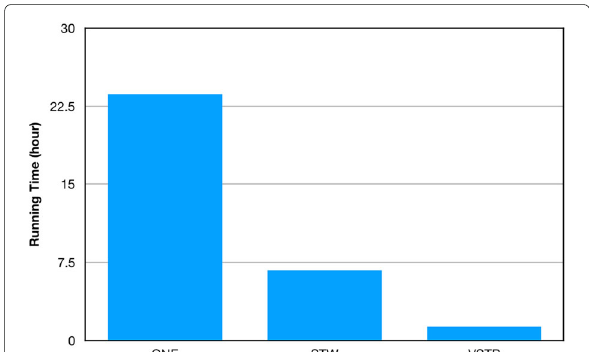
Fig. 10 Running time of three